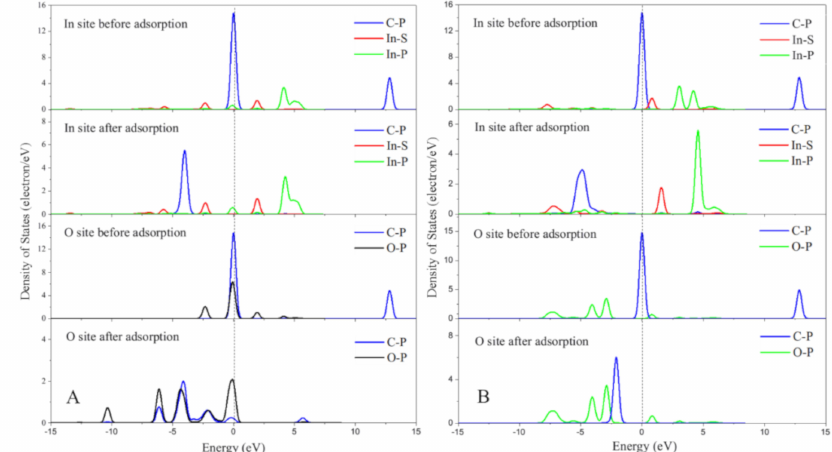
Figure 5. The PDOS of CH 4 before and after adsorption on In and O site of L-model ( A ) and B-model ( B